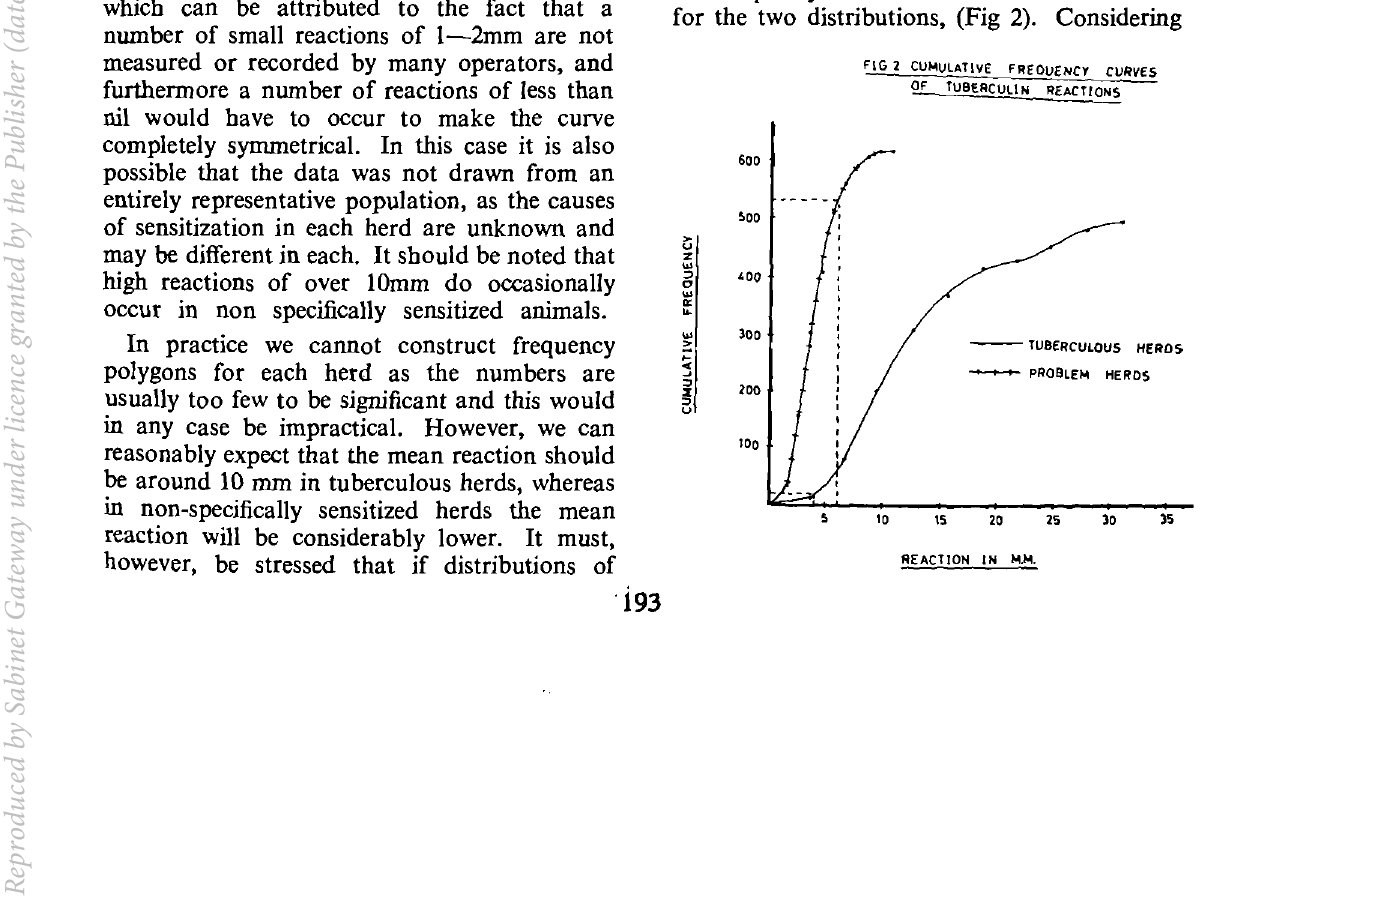
FIG 2 CUIo!ULATIVE FREOUENCY CURVES OF TUBERCULI N REACTIONS